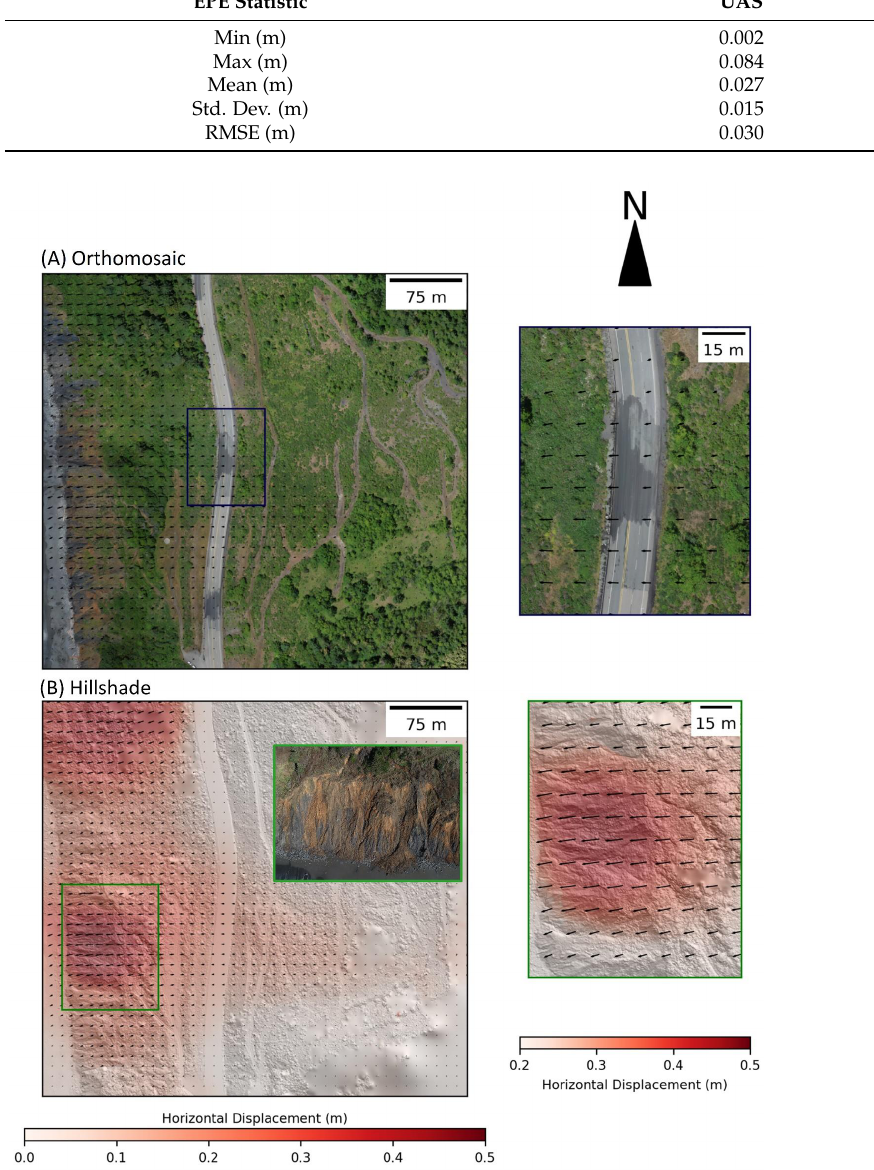
Figure 8. Visualization of the Horizontal displacement computed using SlideSim on the UAS data over the larger extents. Vectors are scaled 20×.